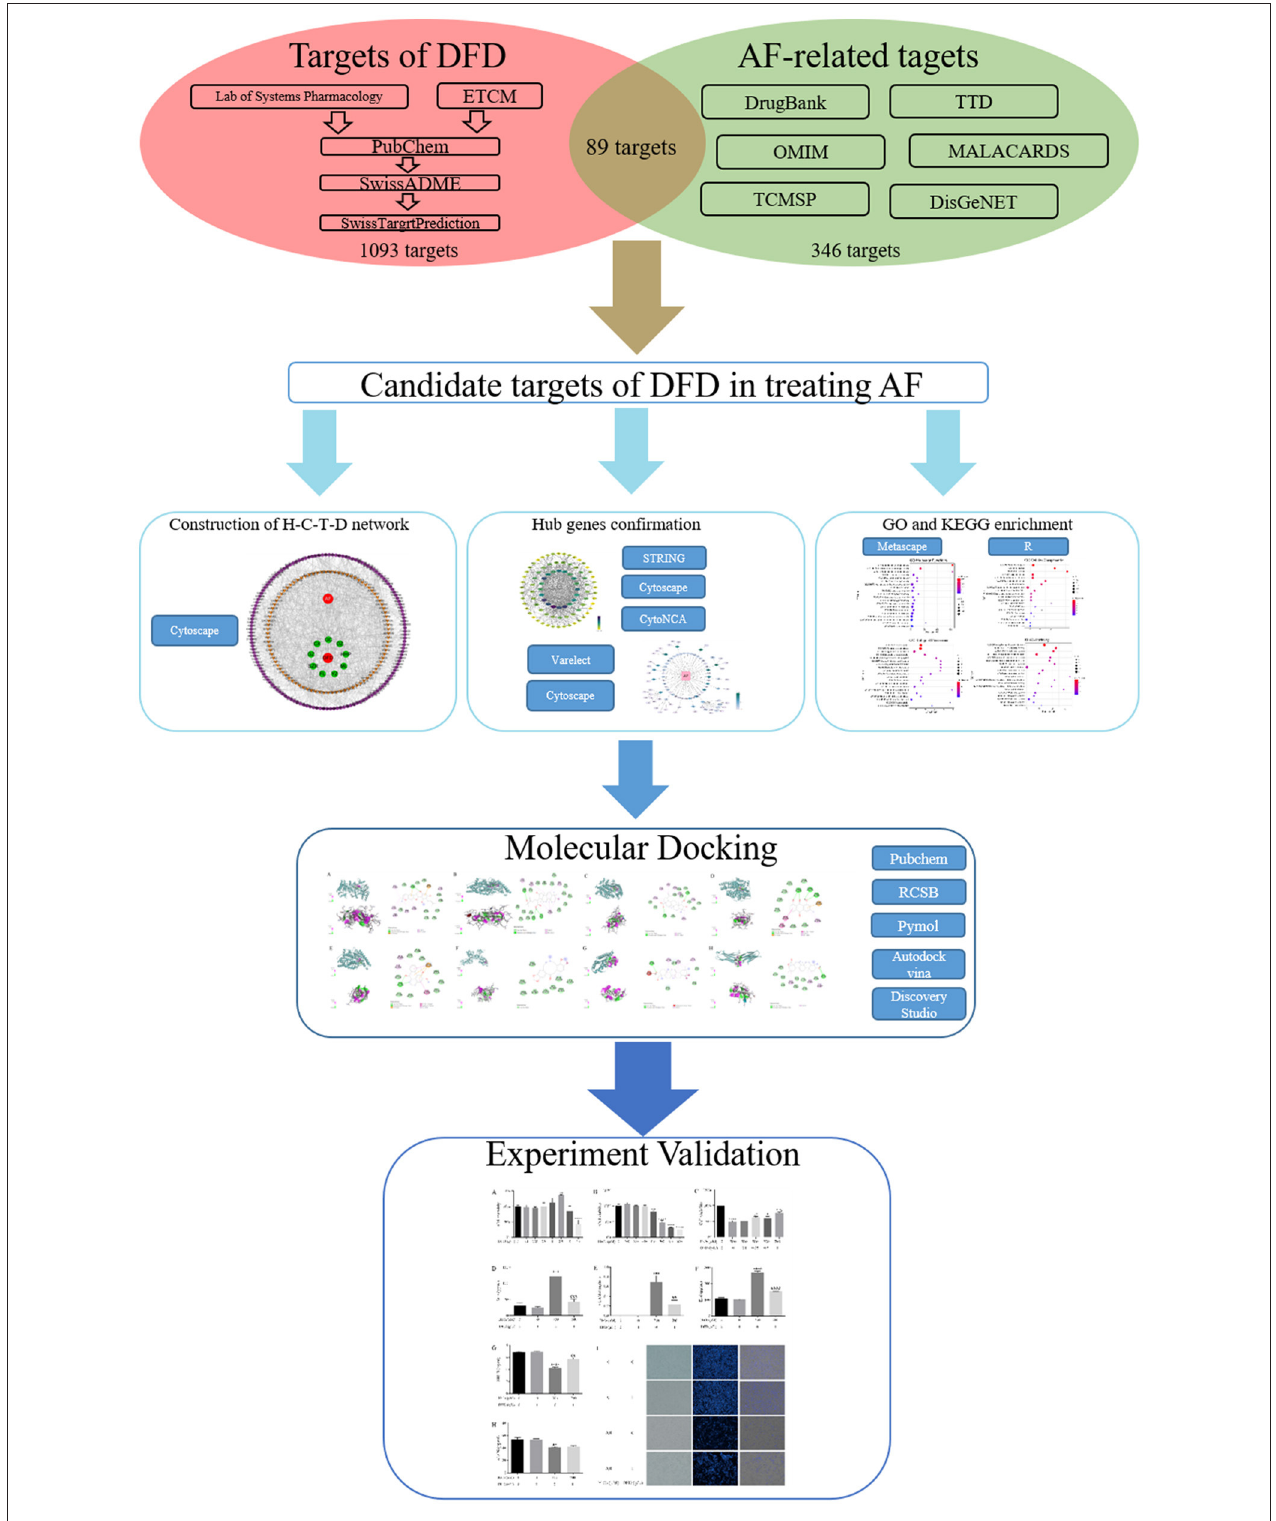
FIGURE 1 | The flow chart of this work.